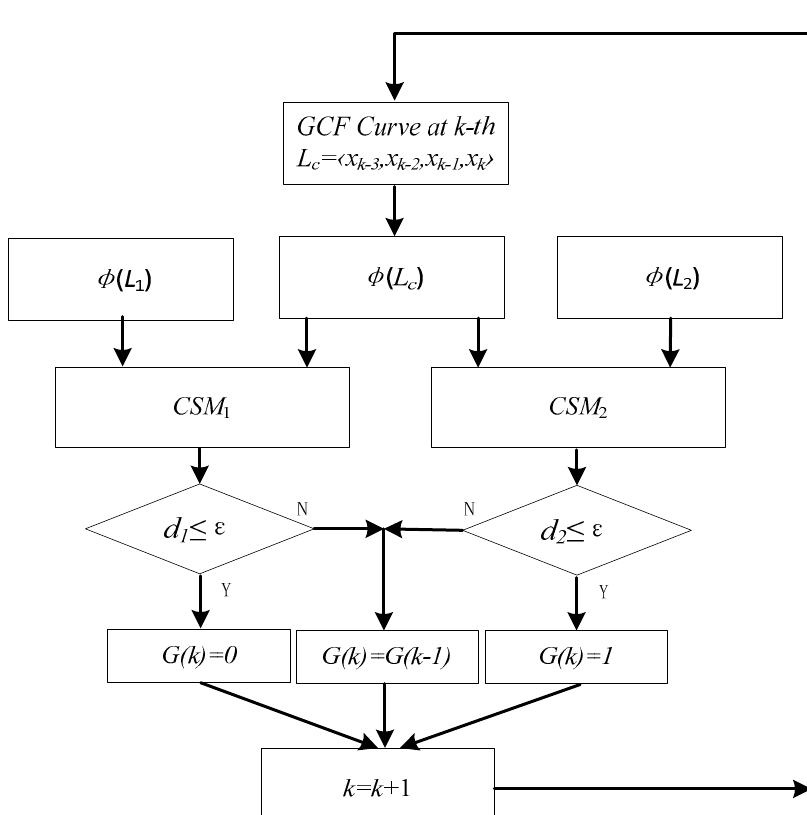
Figure 7. Flow chart of real-time gait detection algorithm. CSM, curve similarity model.